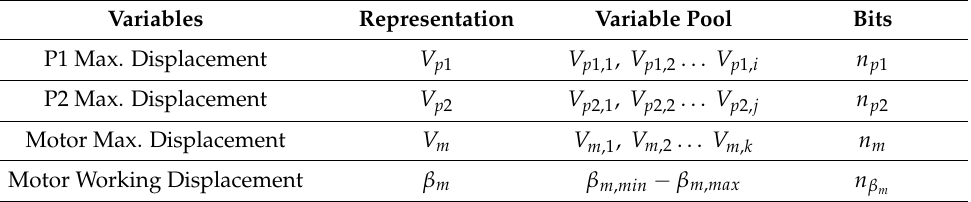
Table 1. Design Variables and Range. Variables Representation Variable Pool Bits